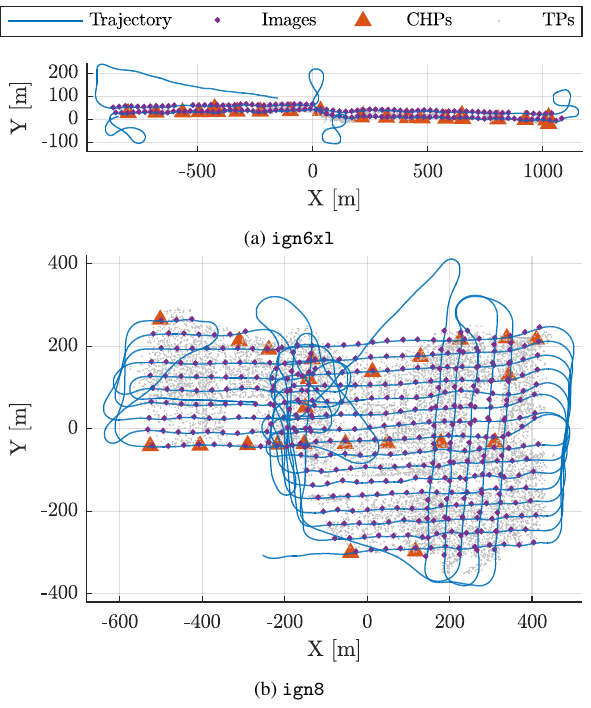
Figure 8. The trajectory of some of the released flights, with the position of the images, the available checkpoints on ground, and some of the tie-points as detected by Agisoft Metashape.